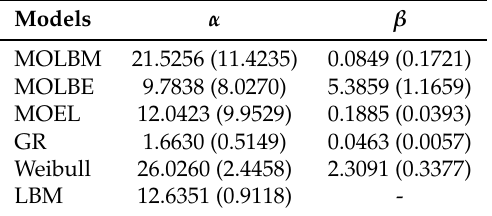
Table 8 indicates the − log L , AIC, CAIC, BIC, HQIC, A ∗ , W ∗ , KS and p -value of the considered